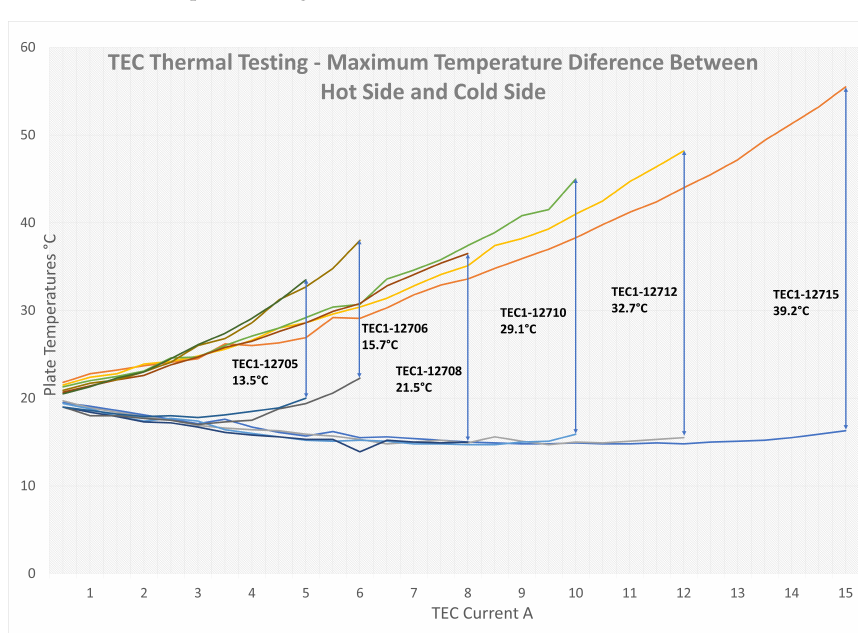
Figure 7. Test setup for testing thermoelectric cooler (TEC).